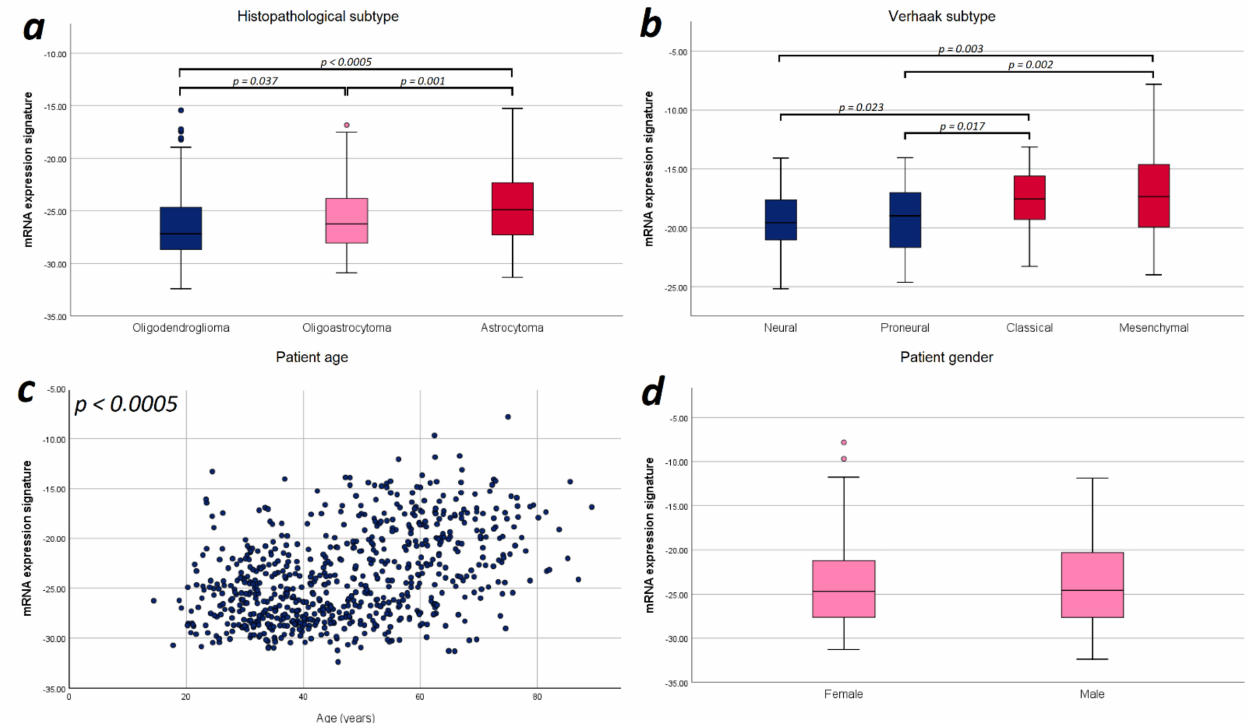
Figure 4. Illustration of the distribution of mRNA expression signature according to relevant prognostic factors. ( a ) Histopathological subtype: Significant differences in the mRNA expression signature were found between astro- cytomas, oligoastrocytomas and oligodendrogliomas. ( b ) Verhaak tumor subtype: The mesenchymal and classical Verhaak tumor subtypes showed a significantly higher mRNA expression signature compared to neural and proneural subtypes. ( c ) Patient age: The mRNA expression signature significantly correlated with the patient age. ( d ) Patient sex: No statistically significant difference in the mRNA expression signature was observed between female and male patients. Only p -values with significant differences were included in this